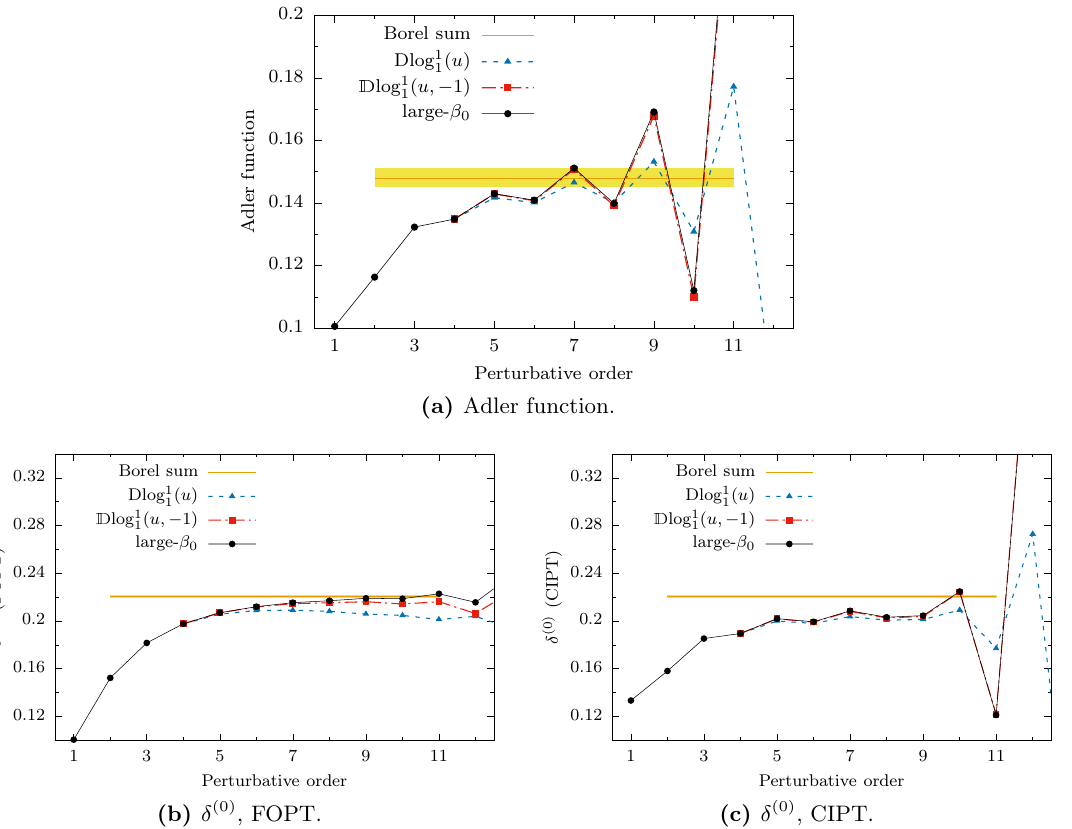
Figure 6. Results from the use of the approximants Dlog 1 Perturbative expansion of the Adler function. (b) (cid:14) (0) in FOPT, and (c) (cid:14) (0) in CIPT.